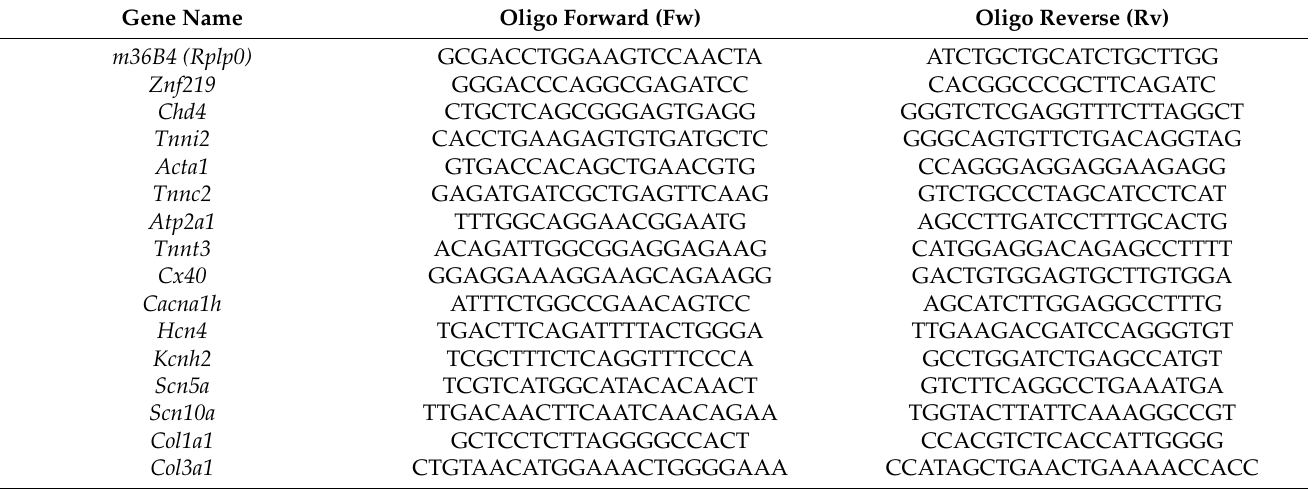
Table 1. Oligonucleotide primers used for qPCR.